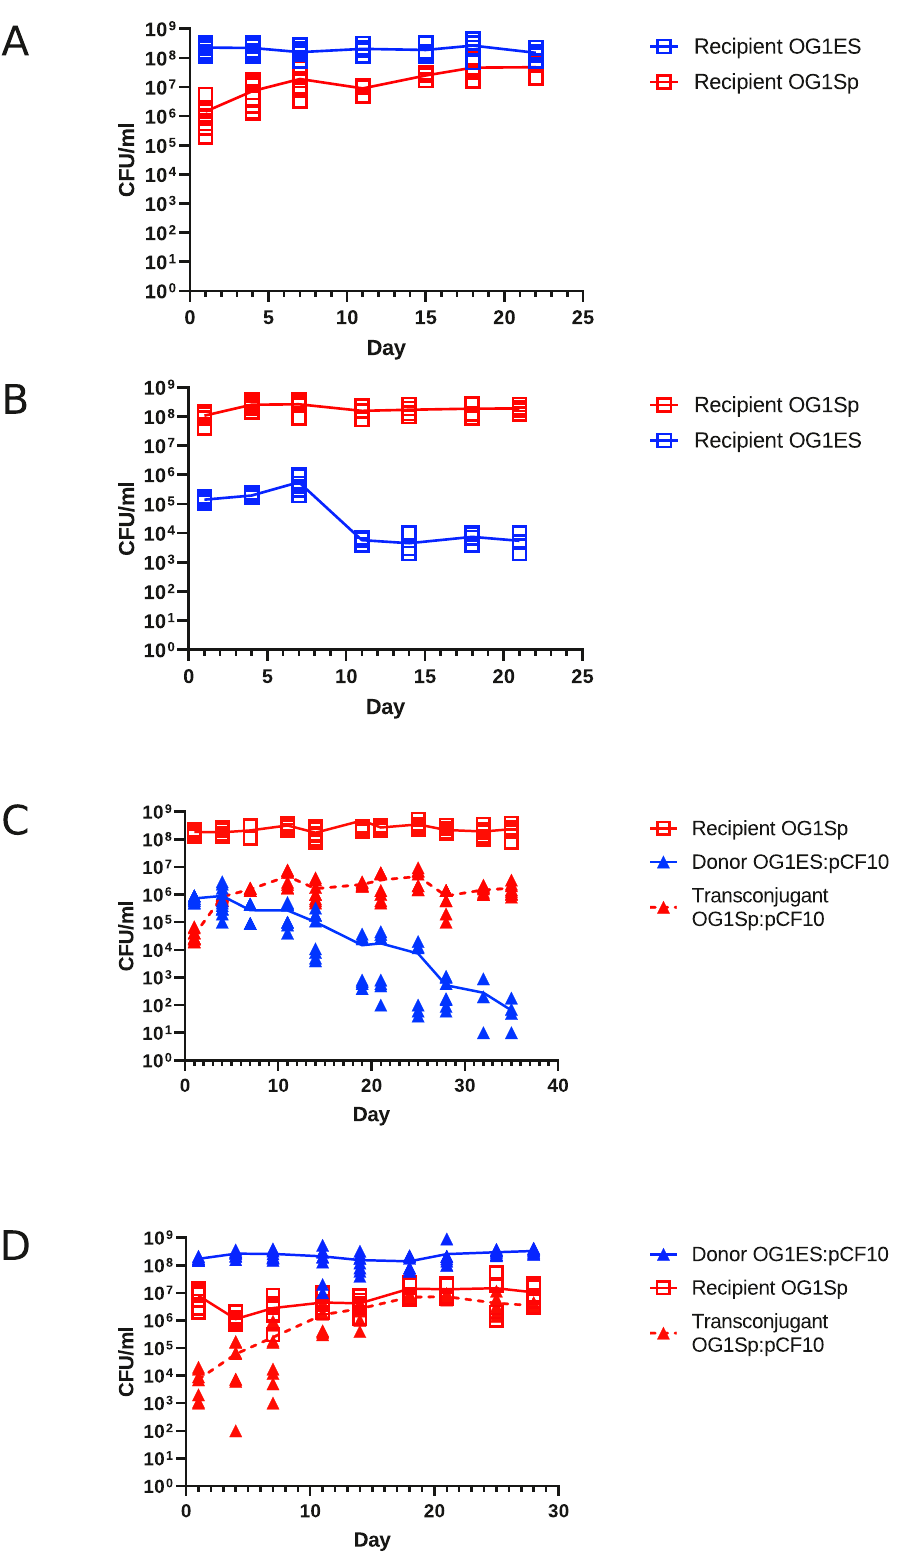
Fig. 2 Role of strain background in niche invasion, invasion immunity, and pCF10 transfer. Experiments analogous to those shown in Fig. 1 were carried out (same enumeration methods and data analysis): A , B show the plasmid-free strain OG1ES and OG1Sp in the resident or invader roles. C , D are analogous to the experiments shown above in Fig. 1A, B, but with OG1ES as pCF10 donor strain and OG1Sp as plasmid-free recipient. OG1ES is marked in blue, OG1Sp in red; the presence of plasmid pCF10 is indicated by a triangle ( Δ ). Numbers of mice (cages): A - 8 (2); B - 8(2): C - 12(3): D - 8(3). Detailed Enumeration data are listed in the Source Data